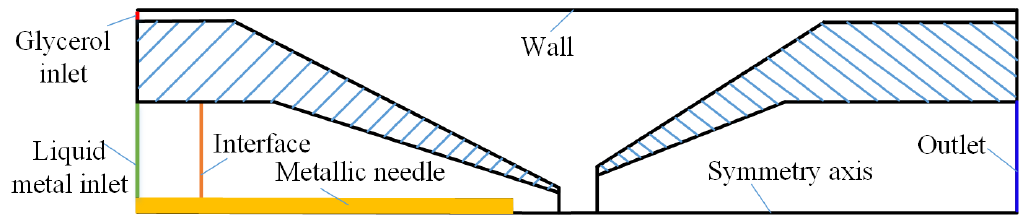
Figure 2. Geometry and boundary condition of liquid metal microsphere formation simulation with the micro-needle induced strategy in co-flowing microchannel.